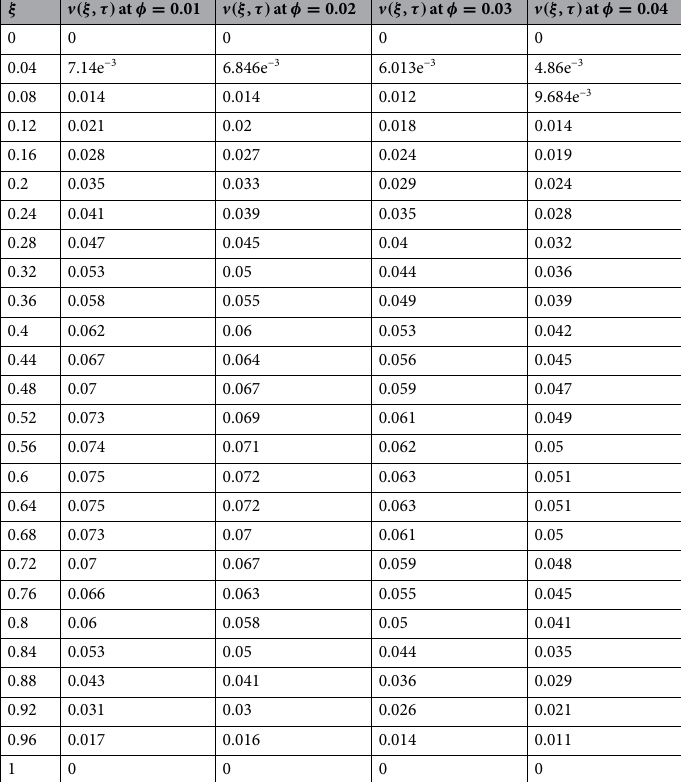
Table 4. Variations in velocity profile against ξ if h (τ) = 1 for different values of φ .